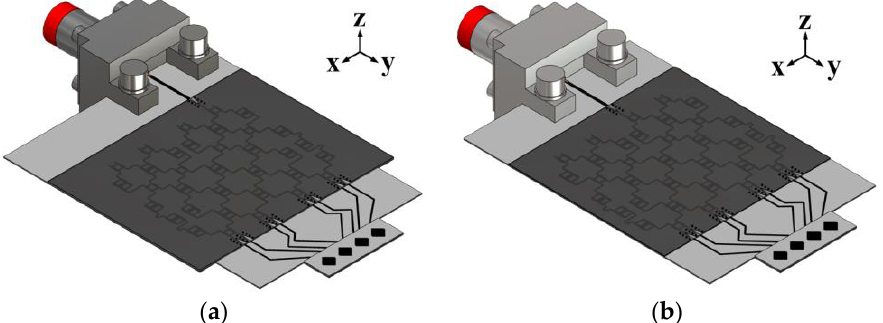
Figure 14. Modified connector model of the proposed antenna: ( a ) port 2 model and ( b ) port 4 model.